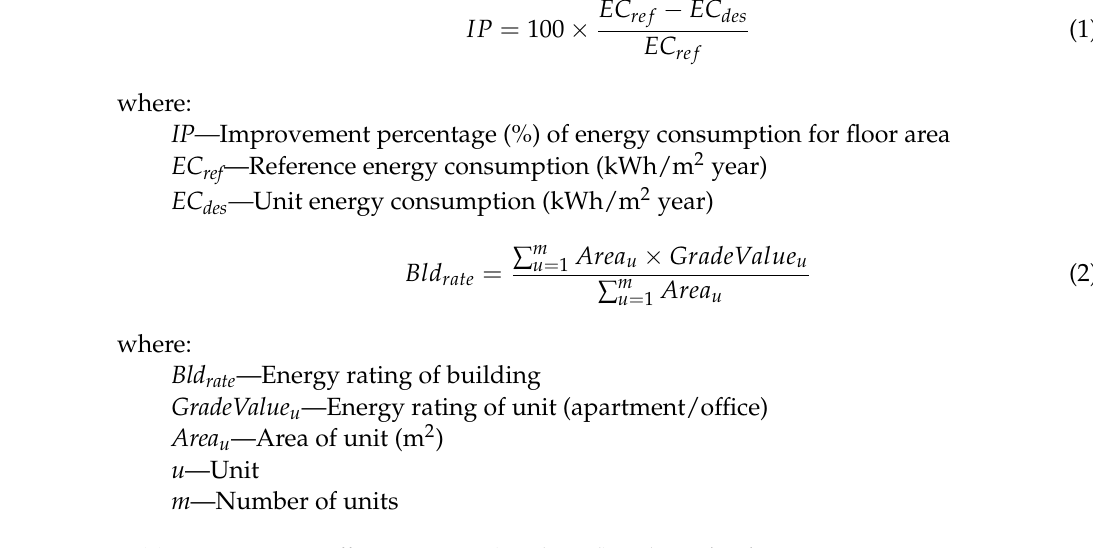
Table 1. Unit energy efficiency rating (residential) with GradeValue u